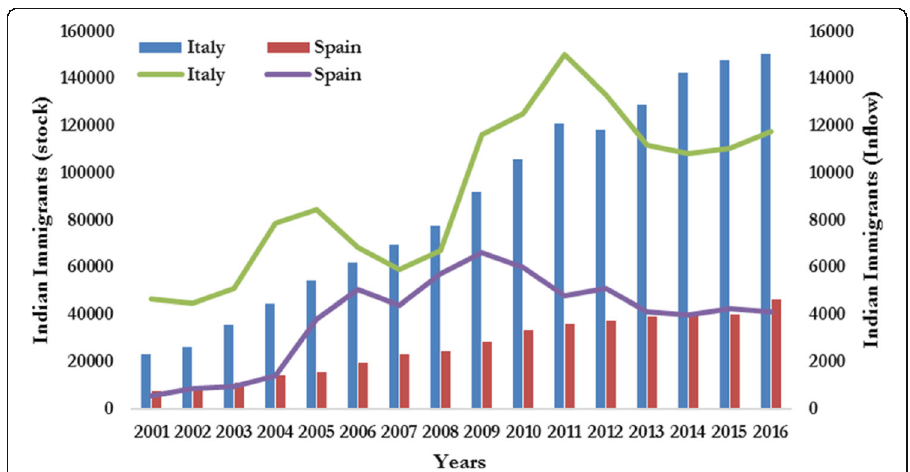
Fig. 2 Annual flow and stock of Indian immigrants to Italy and Spain, 2000 – 2015. Source: own elaboration, from municipal register, 2000 – 2015, INE, Spain, and ISTAT,